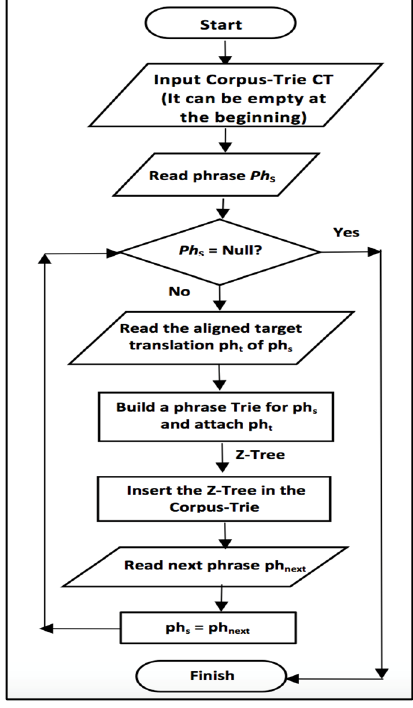
Figure 1. Flowchart of the CT system.